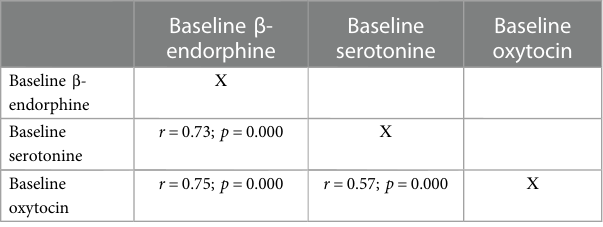
Baseline serotonine